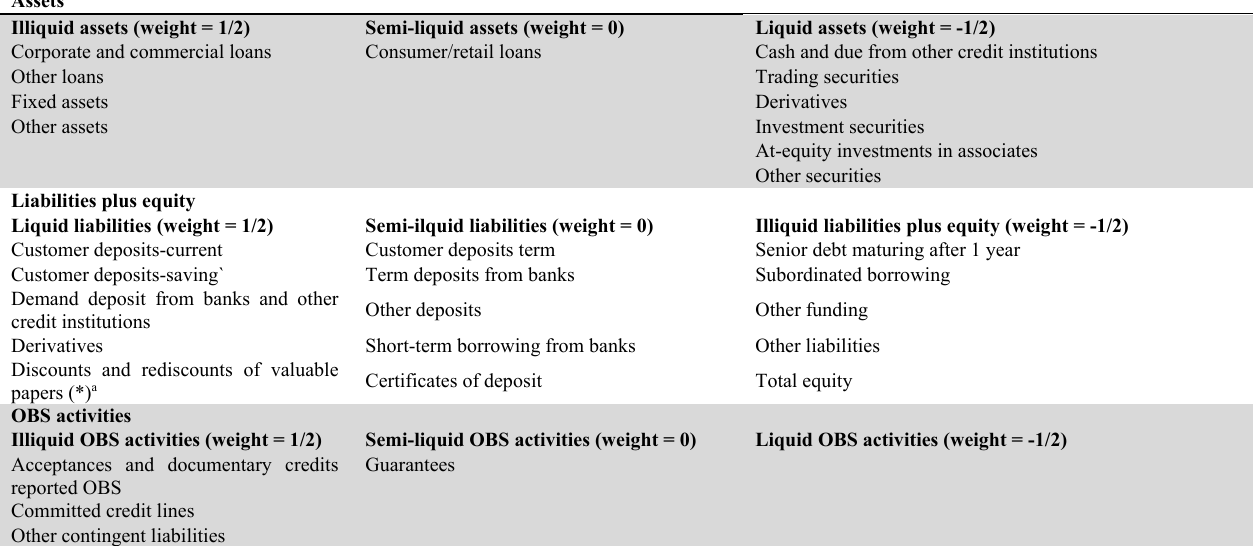
Liquidity classification of bank activities and construction of two liquidity creation